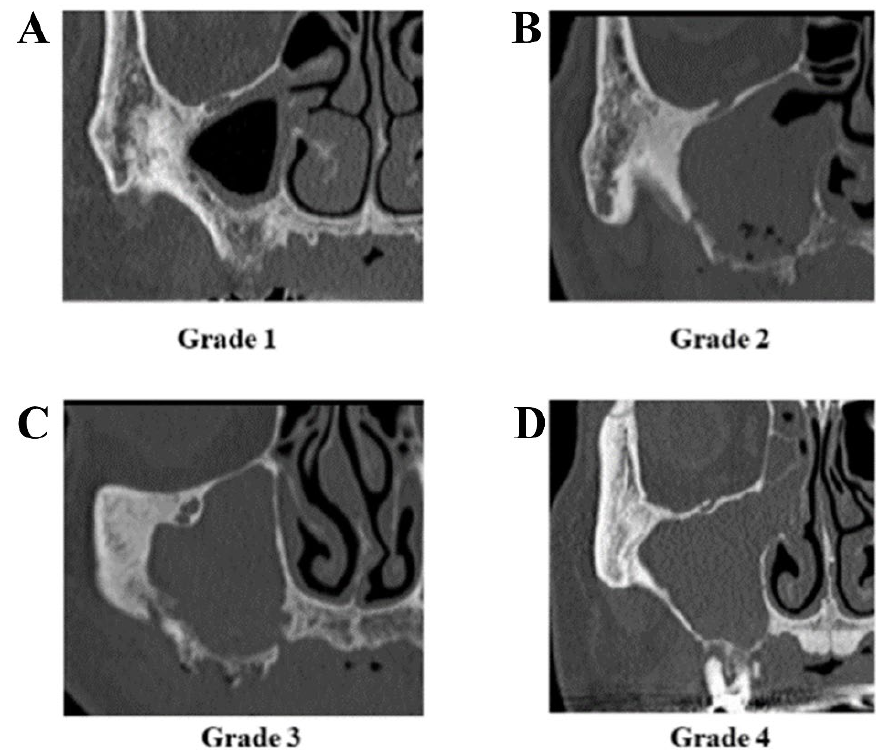
Figure 1. Grade of maxillary sinusitis. ( A ) Limited to the floor of the sinus (grade 1), ( B ) spreading over the entire maxillary sinus, but an air cavity remains (grade 2), ( C ) spreading to the whole maxillary sinus (grade 3), ( D ) spreading to ethmoid sinus (grade 4).